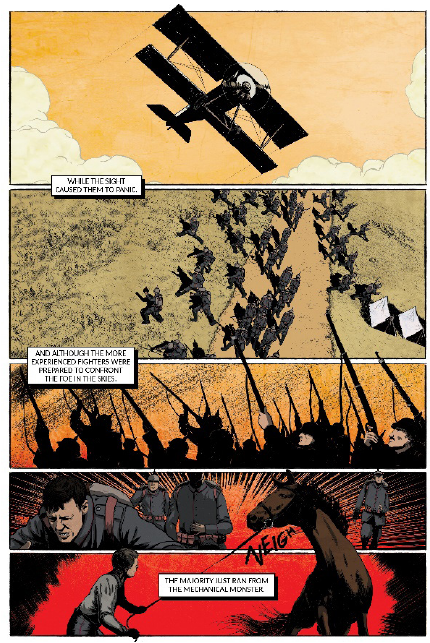
Figure 1. An example of a comic page that shows an action taking place almost simultaneously in multiple locations (source: Studio Mitkus